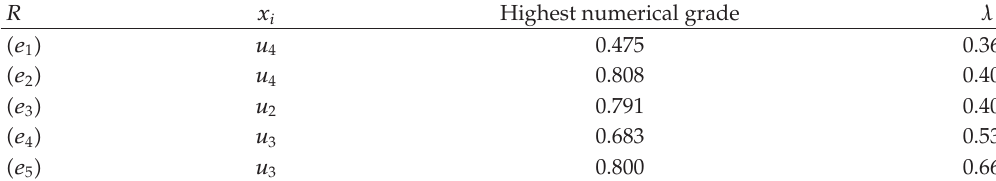
Table 10: Grade table of